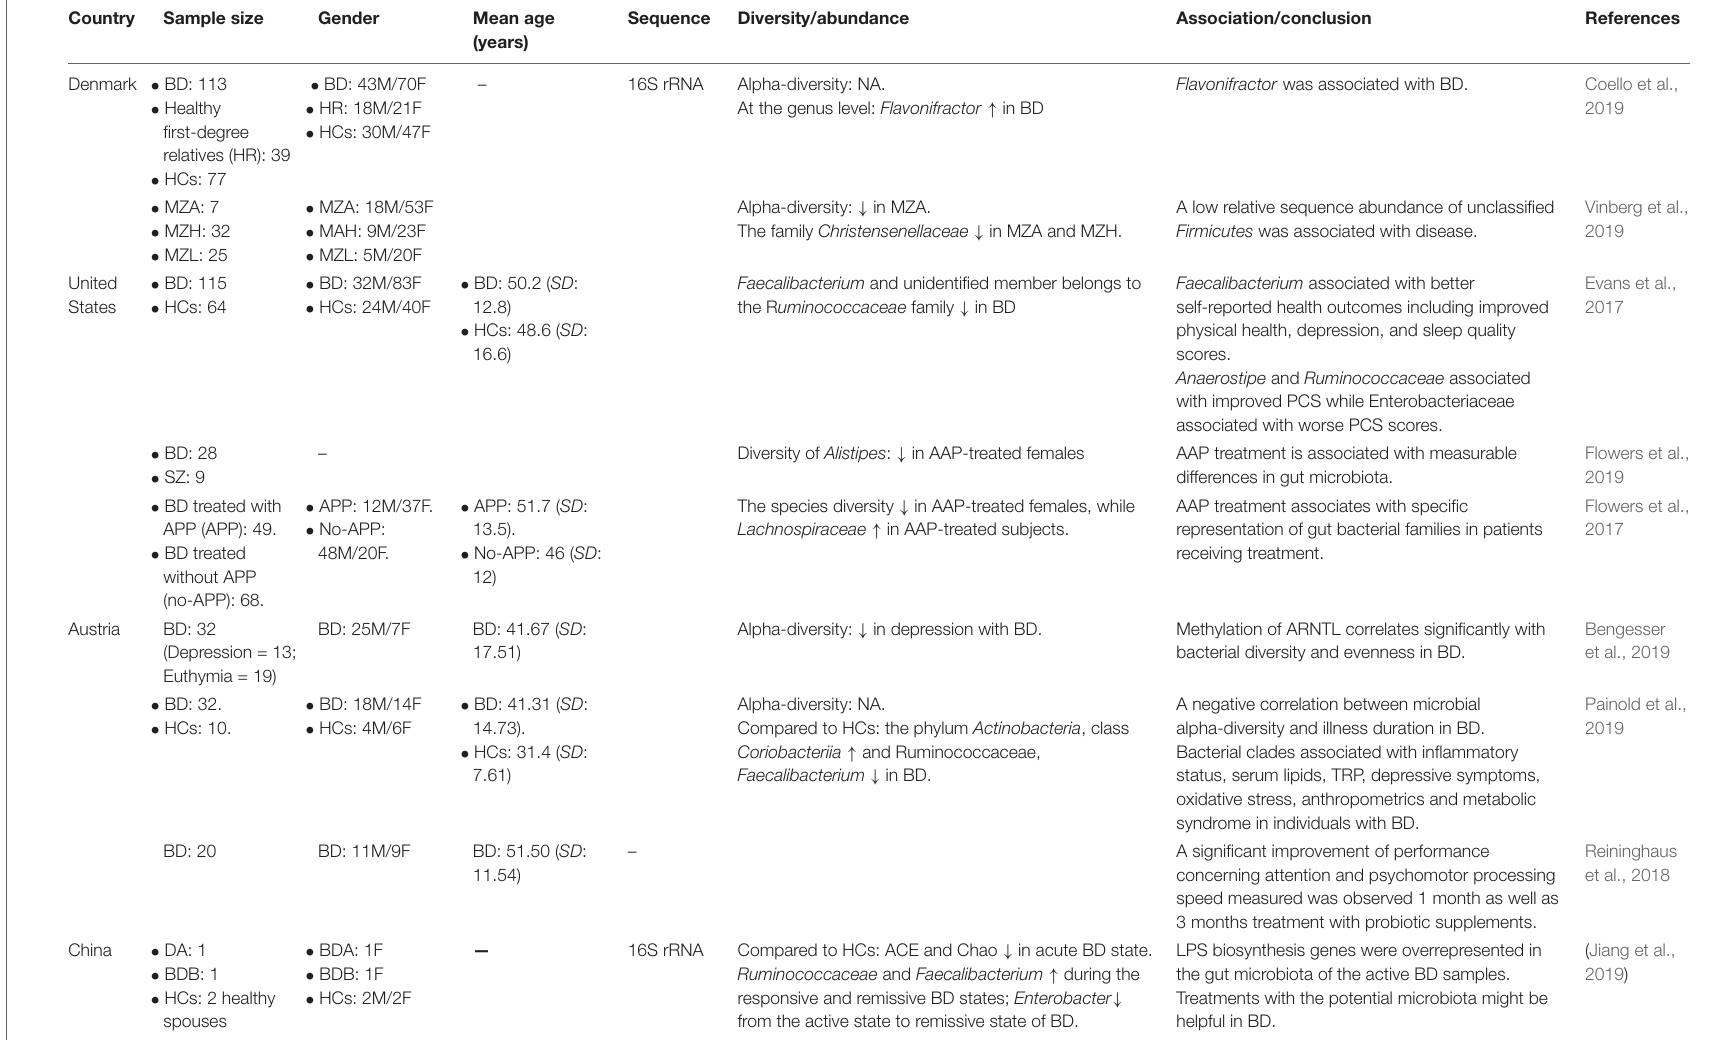
TABLE 1 | Clinical studies on the relationship between gut microbiota and bipolar disorder (BD). Country Sample size Gender Mean age